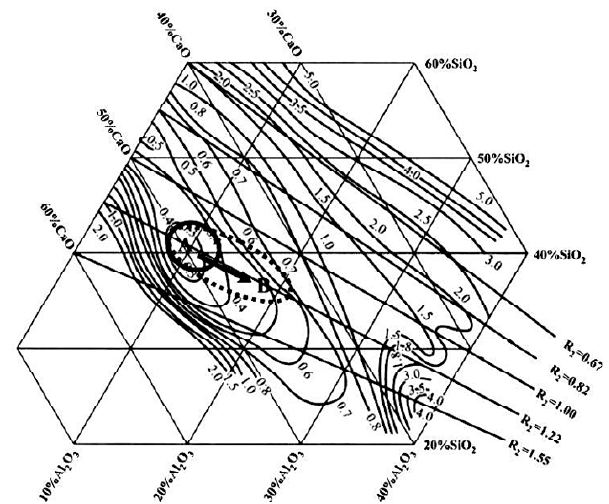
Figure 1. Isoviscosity diagram of the SiO 2 –CaO–Al 2 O 3 ternary slag system (1500 °C, Pas) [1] . BF operation problems of high-Al 2 O 3 slag stem from the increase in slag viscosity; thus, it is necessary to reduce slag viscosity while maintaining the proper melting point of slag. Although increasing slag basicity helps to improve slag viscosity, it significantly increases the melting point of the slag [9]. However, lowering slag basicity helps to reduce its melting point, further deteriorating its desulfurization ability of slag [10]. The addition of proper MgO can increase the liquid-phase region, reduce the melting point of slag, and improve its fluidity. T. Paananen [11] found that MgO significantly accelerates the reduction of magnetite to iron. M. Matsumura et al . [12], J. Chang [13], and X. Qin et al. [14] found that proper MgO can decrease the melting temperature and increase the desulfurization ability of slag. Therefore, the current popular method for adjusting the metallurgical properties of high-Al 2 O 3 BF slag is to add MgO into the slag. Regarding the influence of MgO on slag viscosity, Figure 2 shows the isoviscosity diagram of the CaO–SiO 2 –Al 2 O 3 –MgO quaternary slag system with a SiO 2 content of 35% [1]. With the addition of MgO, slag viscosity is reduced. For BF slag with a basicity of about 1.15, adding a certain amount of MgO gives a proper slag viscosity within the range of 0.3 to 0.4 Pas.